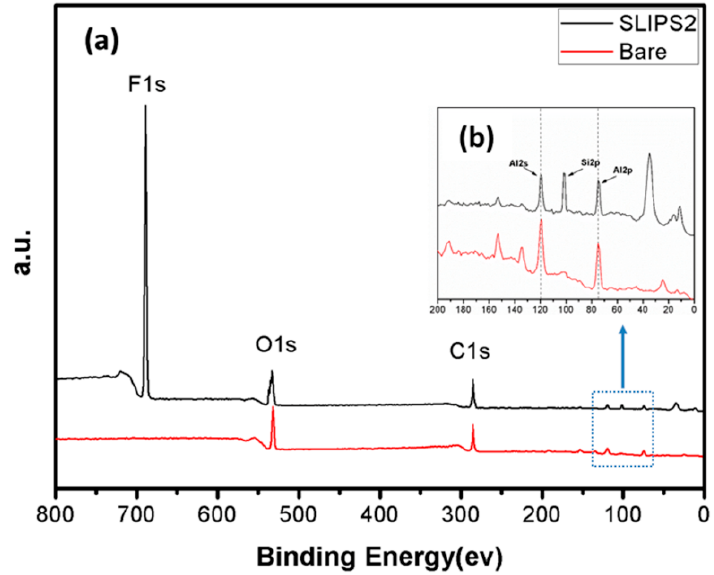
Figure 2. The FTIR spectrum of bare sample and SLIPS2.